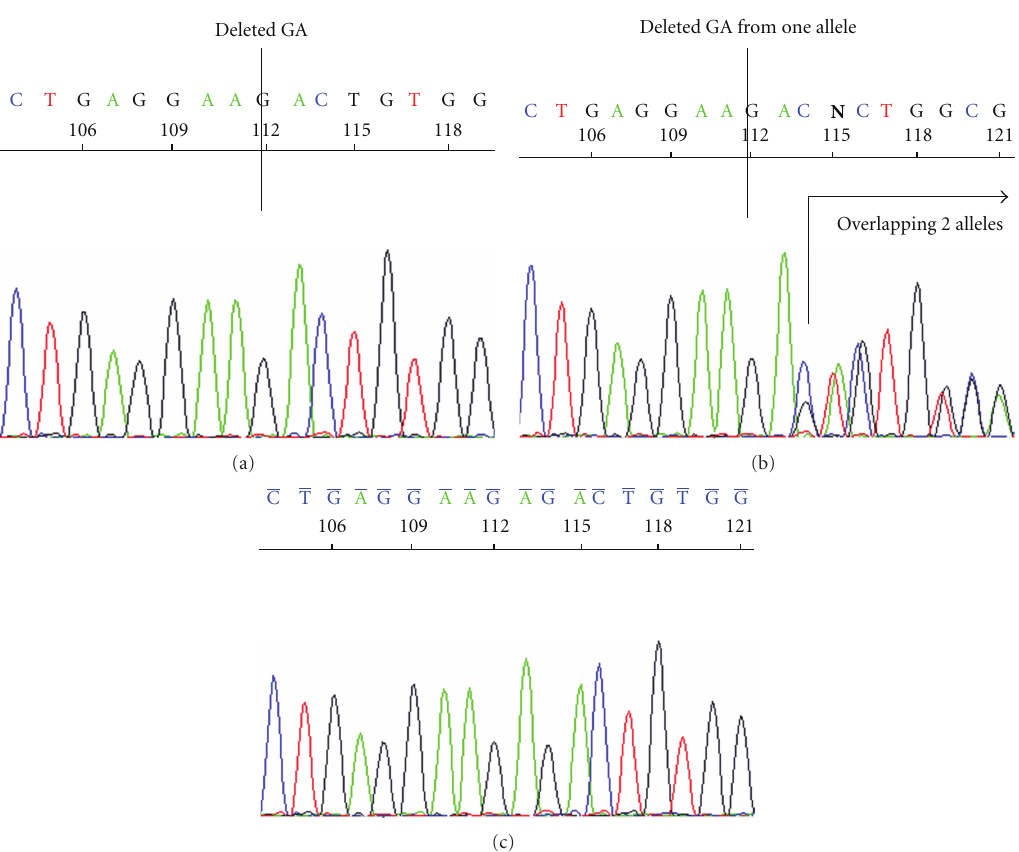
Figure 1: Sequencing exon 3 of SLC2A2 for family (1) showed the following (a) For patient, two bases (GA) were deleted in a homozygous pattern (c.253 254delGA). (b) Individuals 1101, 1201, 1202, 1203, 1204, 1206, and 1301 were heterozygous, for the above deletion (c.253 254delGA). (c) Individuals 1104, 1205, and 1303 were homozygous normal (mutation c.253 254delGA is not